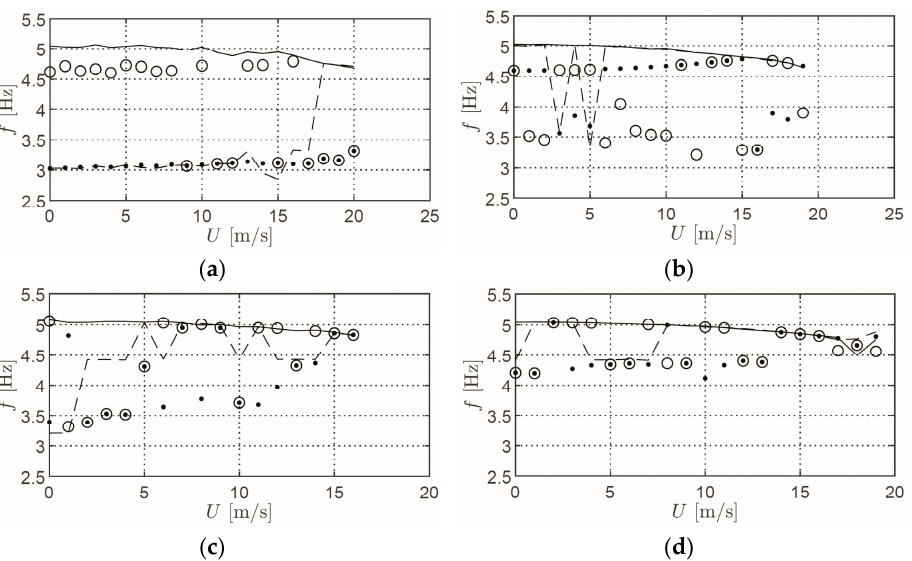
Figure 25. System frequencies (heave ( f h ) and pitch ( f α )) extracted from the MITD method at different wind speeds. (o) f α , ( . . . ) f h , ( − − ) f h lowpass-filtered signal FFT, (—) f α lowpass-filtered signal FFT. ( a ) heave-dominant, Setup 1; ( b ) pitch-dominant, Setup 1; ( c ) heave-dominant, Setup 2; ( d ) pitch-dominant, Setup